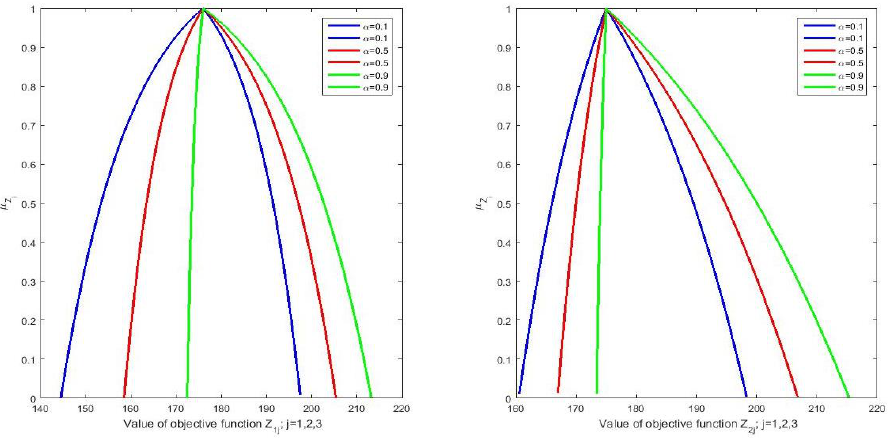
Figure 5. Possibilities distribution of first and second objectives for